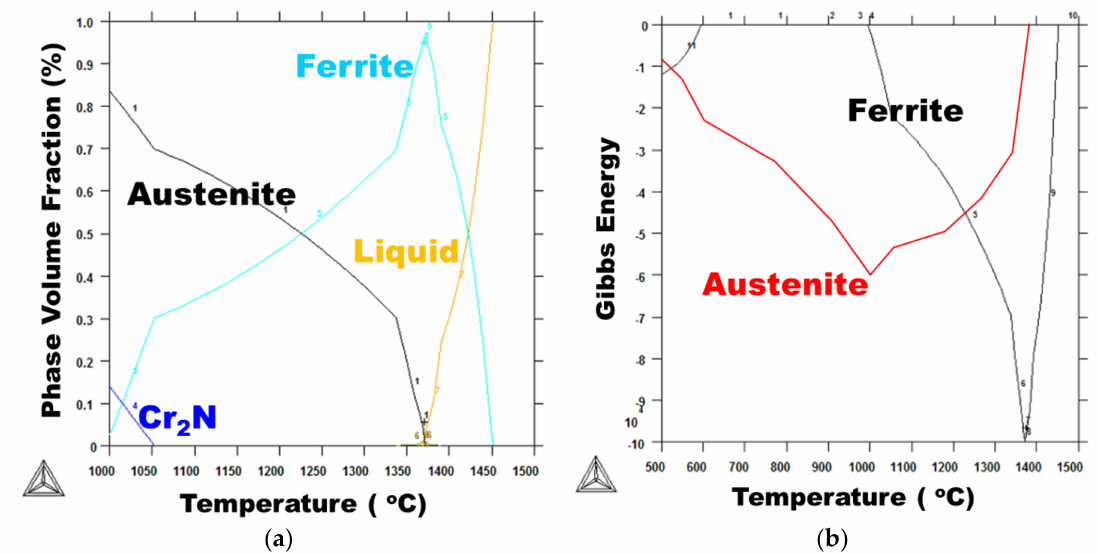
Figure 15. Phase volume fraction and Gibbs free energy diagram versus temperature calculated by Thermo-Calc TM (Version 6.0, TCW5, Database: TCFE6, Thermo-Calc Software, Stockholm, Sweden):